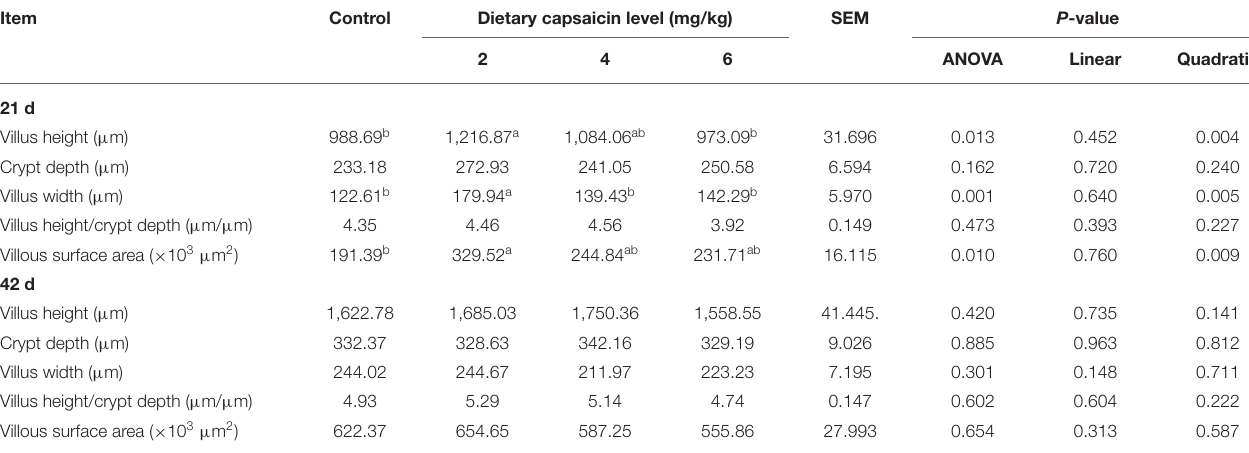
TABLE 8 | Effects of different levels of capsaicin on the jejunal morphology of broilers.